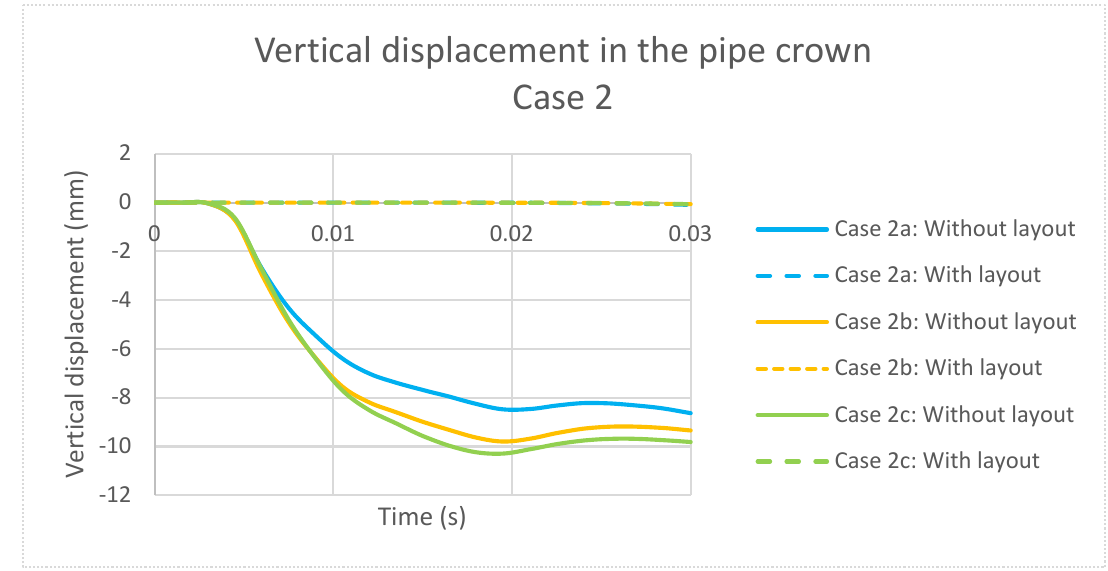
Figure 8. Vertical displacements in the pipe crown for case 2.